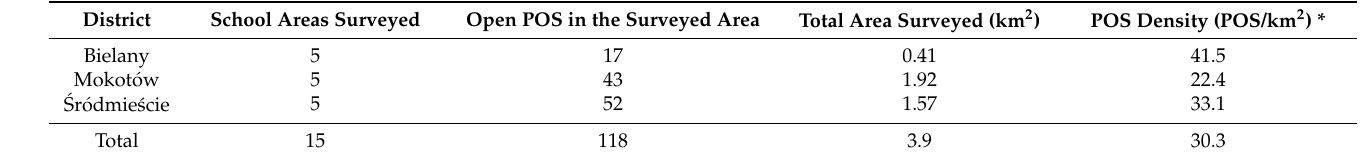
Table 3. Density of POS per km 2 around schools by